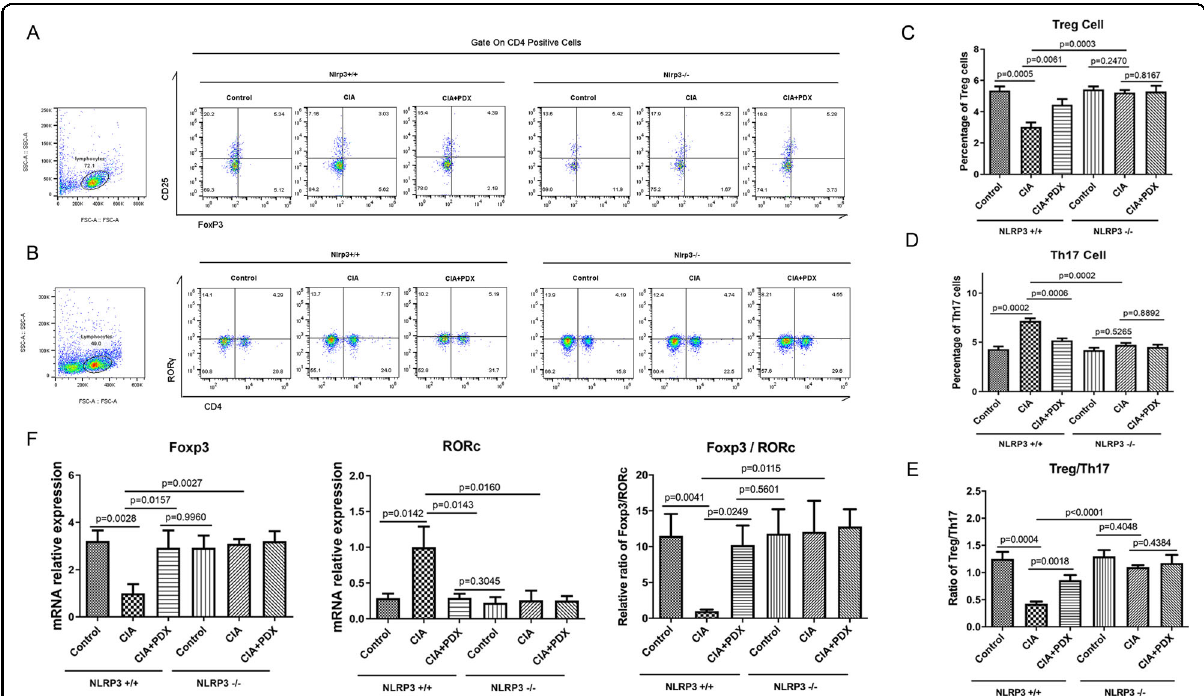
Fig. 5 Effect of PDX in restoring Treg/Th17 cell balance in Nlrp3 − / − CIA mice. A – D Percentages of T h 17 cells and Tregs in PDX-treated Nlrp 3 + / +